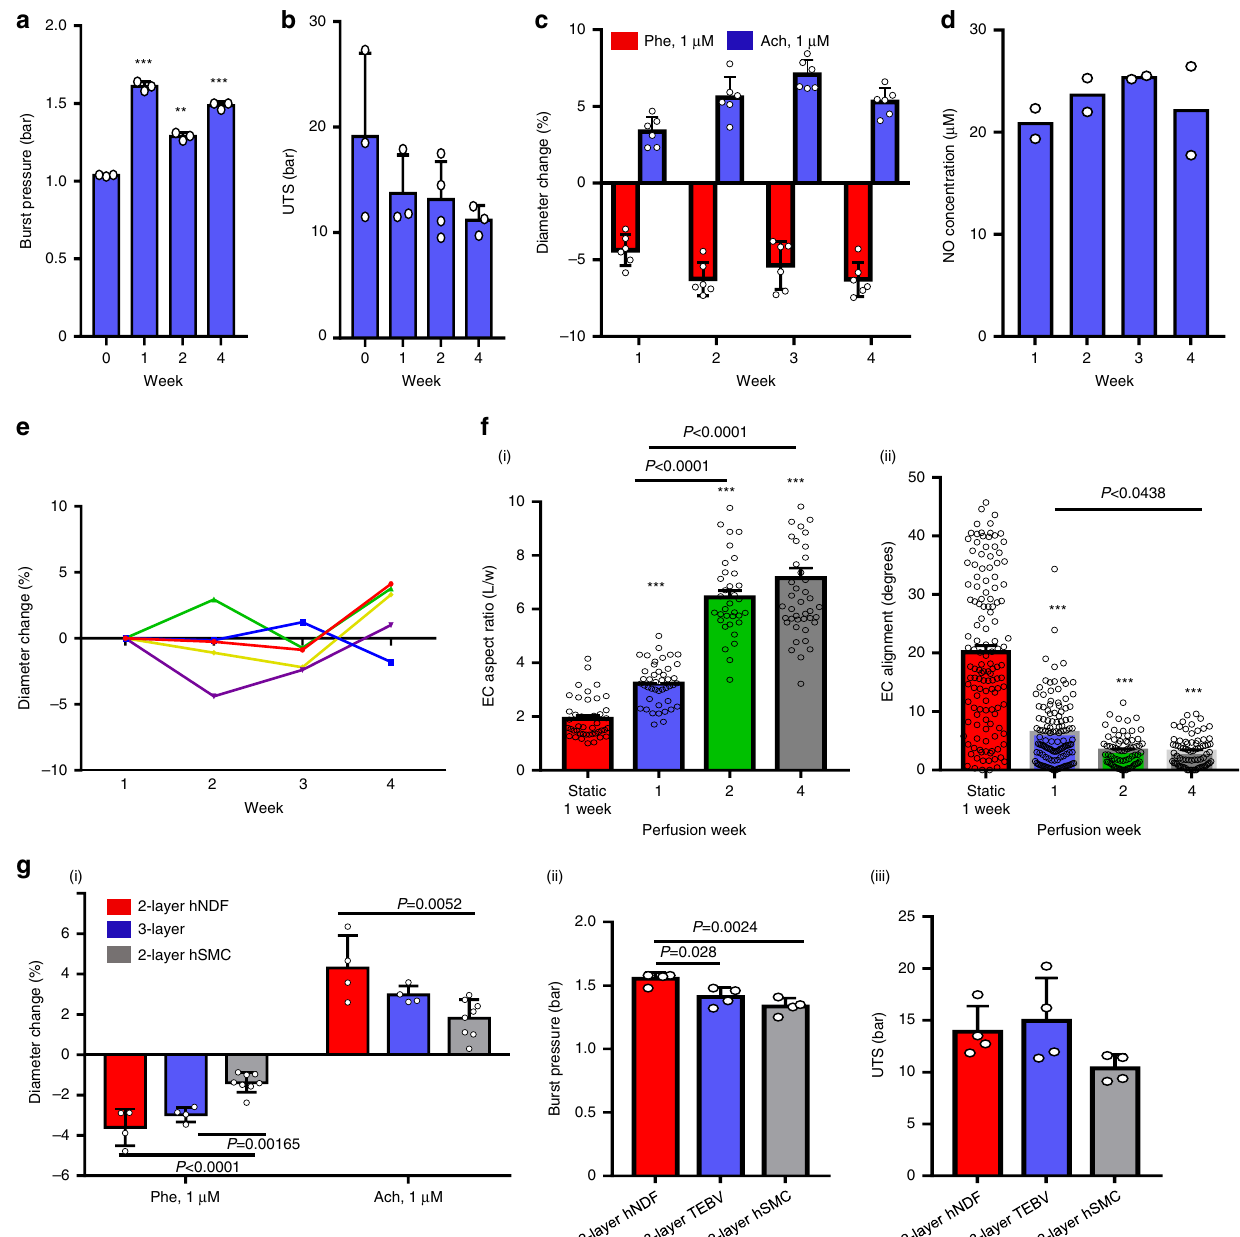
Fig. 2 TEBV functional properties and stability during 4 weeks of perfusion. Burst pressure ( a ) and ultimate tensile stress (UTS) ( b ) of endothelialized TEBVs perfused for 1 – 4 weeks (mean ± S.D., n = 3 TEBVs, ** P = 0.00031, *** P < 0.0001 compared to week 0 without perfusion by one-way ANOVA). c Vasoactivity of endothelialized TEBVs perfused for 1 – 4 weeks (mean ± S.D., n = 6 TEBVs), Phe: phenylephrine, Ach: acetylcholine. d NO production (total nitrate and nitrite concentration in media) of endothelialized TEBVs perfused for 1 – 4 weeks (mean ± S.D., n = 2 experiments with 4 TEBV per experiment). e The outer diameter is stable over 4 weeks perfusion, without treatment. Each point represents a value from a single TEBV at each time point. f ECs (endothelial cells) elongate (i) and align (ii) under perfusion (mean ± S.E., n = 44,44,34,45 cells for elongation and n = 134,126,70,77 cells for alignment from 2 TEBVs, *** P < 0.0001 compared to static culture by one-way ANOVA and Tukey post hoc test). g Vasoactivity (i), burst pressure (ii) and UTS (iii) of 2- and 3-layer TEBVs after 1-week perfusion (mean ± S.D., n = 8 for 2-layer-hSMC in (i) and n = 4 for others, P values determined by one-way